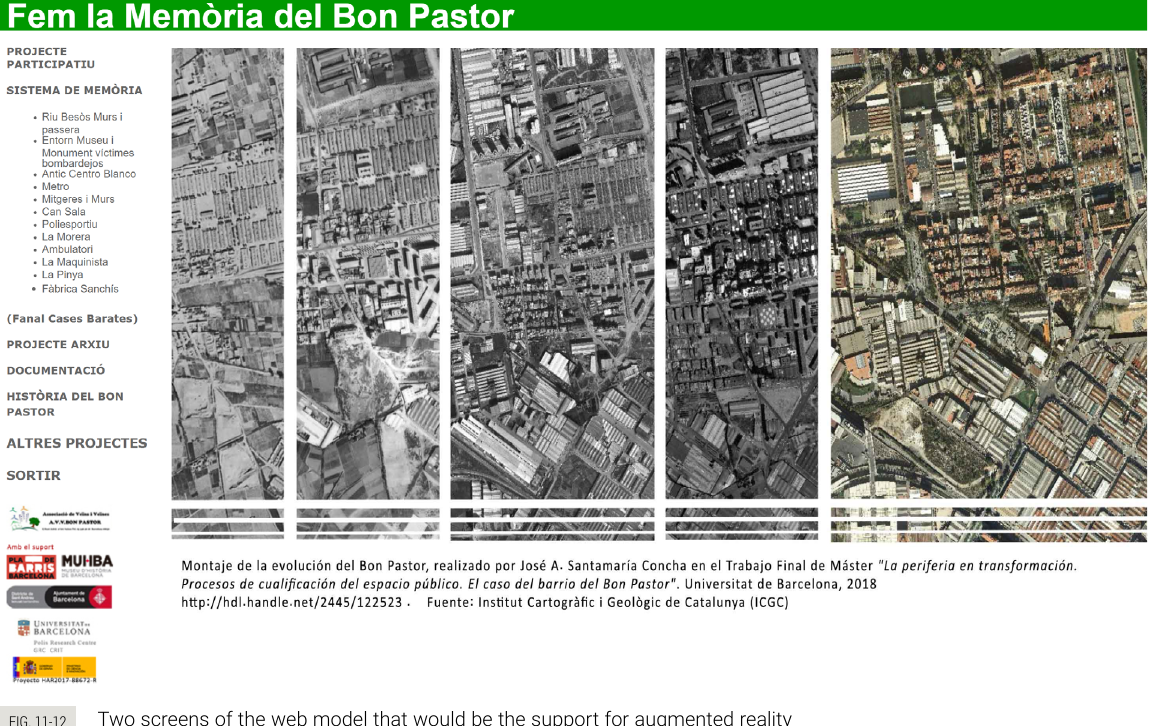
Two screens of the web model that would be the support for augmented reality of the Remembrance System. It involves a documentation and editing activity that should be carried out from “the Fem La Memoria archive” The images come from the photo archive (more than 2,000 photos) provided by the neighbours in the early stages of the participatory